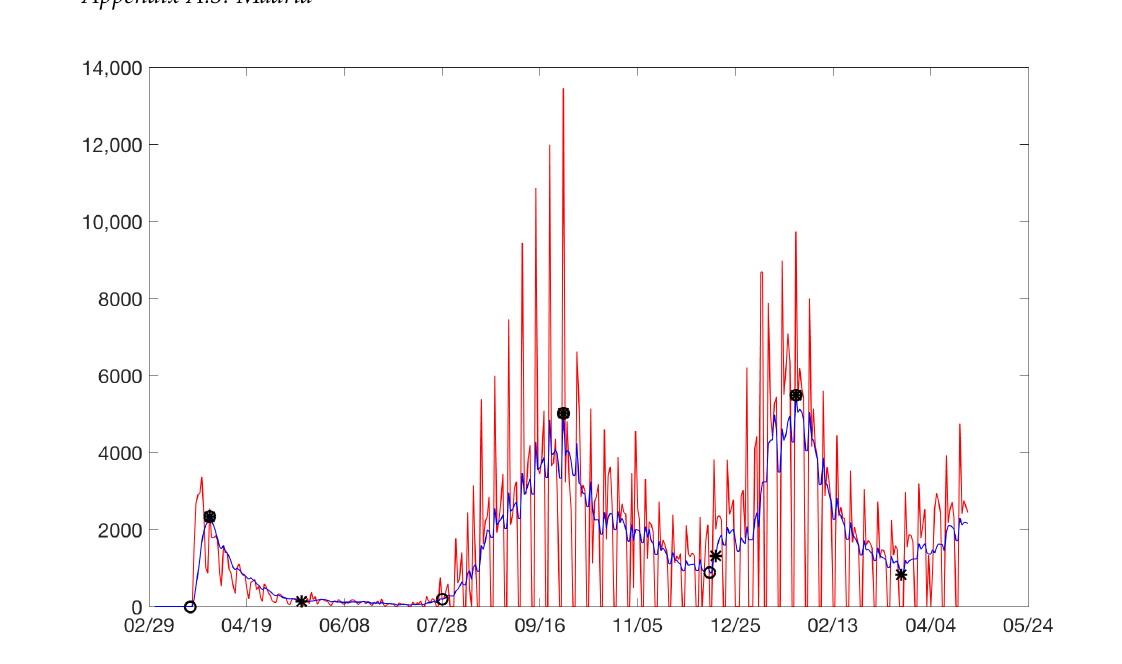
Figure A12. Madrid: on the horizontal axis is the date in days and on the vertical axis are the daily